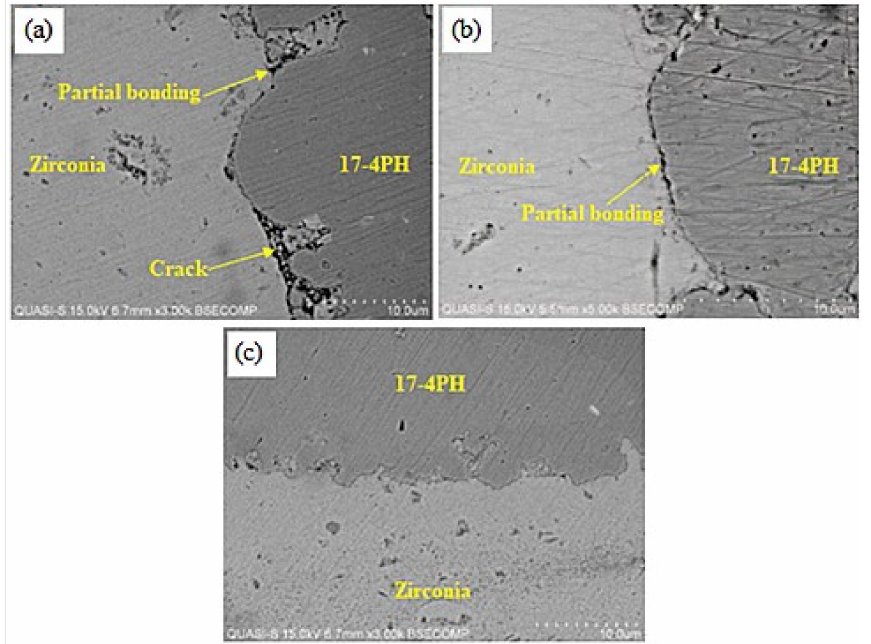
Figure 9. SEM micrographs exhibiting the interfaces of 17-4PH/zirconia micro-sized components sintered for 3 h at various temperatures: ( a ) 1250 ◦ C; ( b ) 1300 ◦ C; ( c ) 1350 ◦ C.